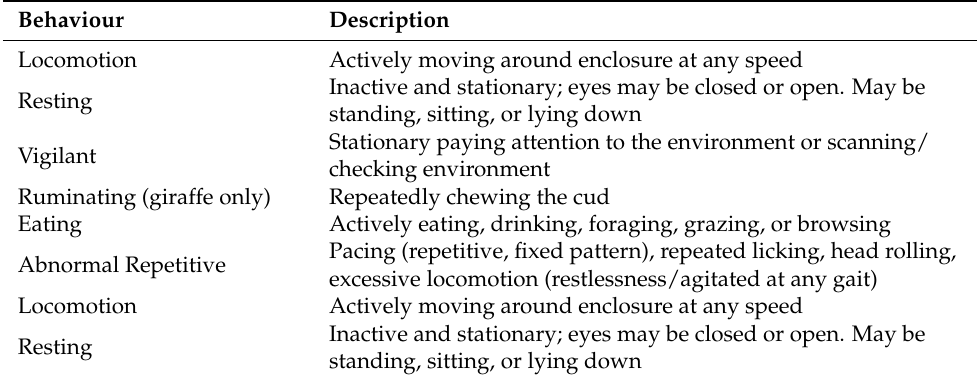
Table 2. Ethogram of behaviours (Adapted from